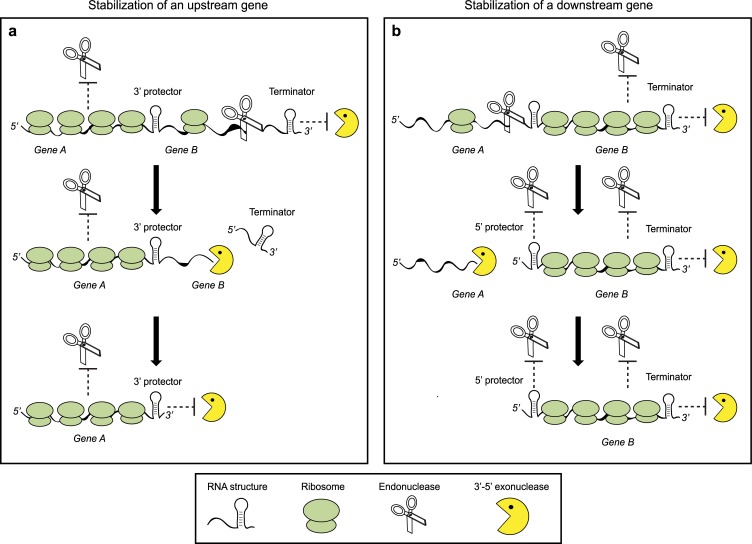
Proposed models for regulation of differential decay rates within the same transcript.(A), A model for stabilization of the upstream gene. The mature polycistronic transcript is protected from 3’-5’ exonucleases by the 3’ terminator hairpin structure. The relatively higher ribosome density over gene A provides protection from endonucleases, leading the RNase E to cleave the gene B segment, which results in the removal of the protective terminator structure, exposing gene B to rapid digestion by 3’-5’ exonucleases. Gene A remains protected by a 3’ RNA structure that blocks processive exonuclease activity. (B) A model for stabilization of the downstream gene. The mature operon is protected by the terminator structure. The relatively higher ribosome densities over gene B guide the initial cleavage to gene A. 3’-5’ exonucleases degrade gene A while gene B maintains its ribosome densities and protective terminator structure. Endonuclease cleavage occurs upstream of a protective 5’ structure that further protects the stable transcript from RNase E.